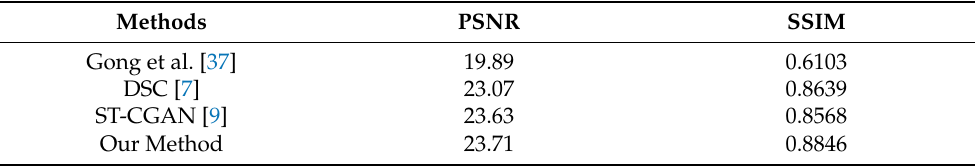
Table 1. Quantitative evaluation results between the existing methods and our work.